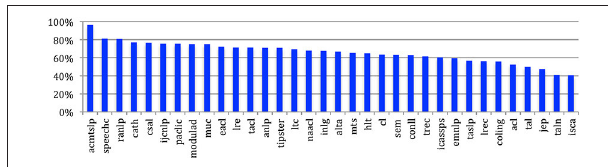
FIGURE 23 | Percentage of completely new authors in the last venue/issue across the sources.